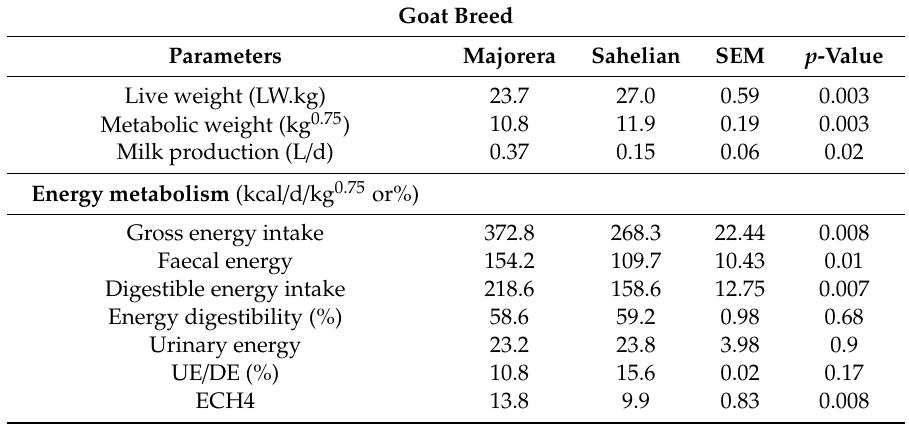
Table 3. Weight parameters, energy and nitrogen uses in lactating goats fed cowpea hay var.58 / 74.